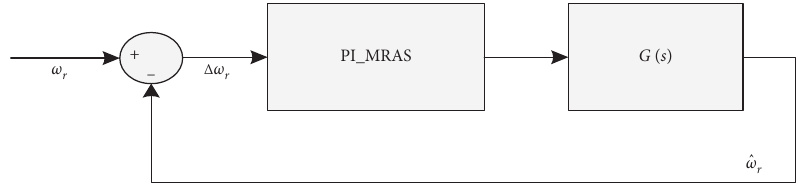
Figure 5: Closed loop block diagram of the stator current-based MRAS speed estimator.